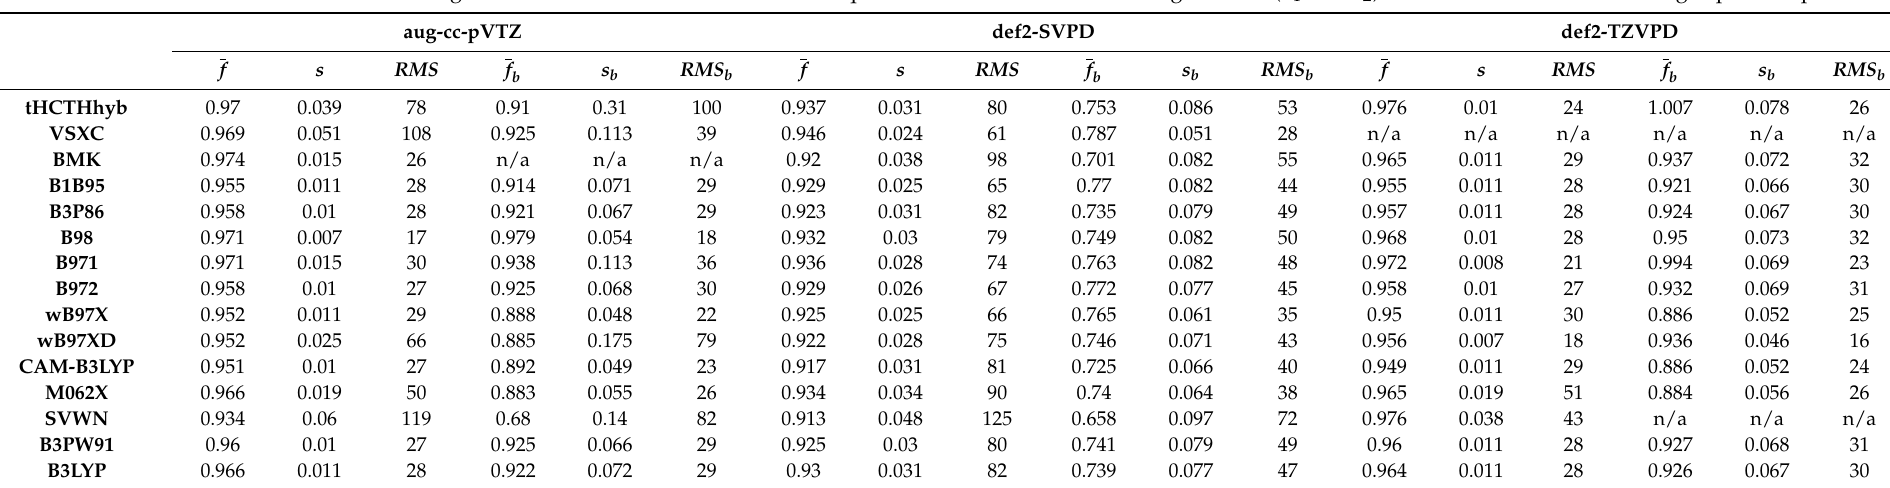
Table 4. Scaling factors for fundamental vibrational frequencies in the lowest excited singlet states (S 1 and S 2 ). Reference values taken from gas-phase experiments.